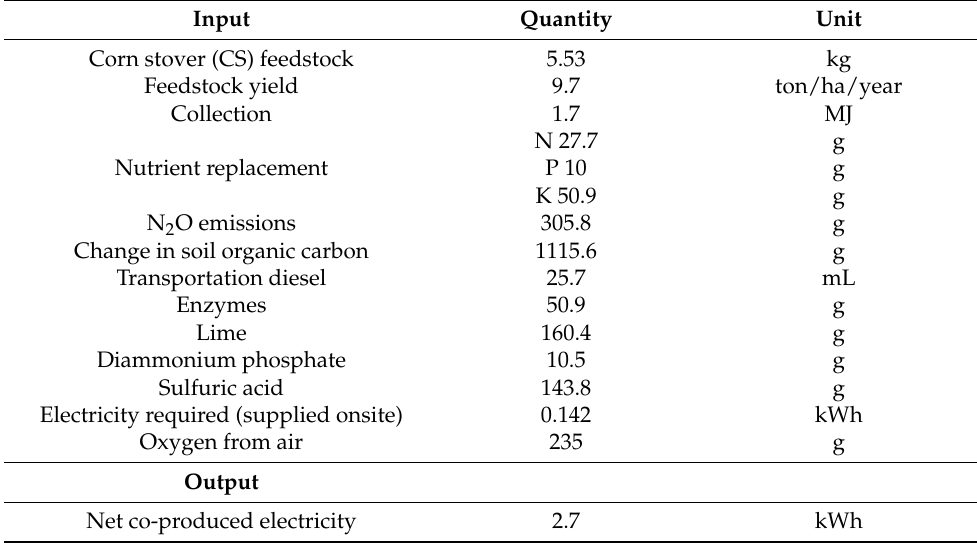
Table 2. summarizes the inputs of feedstock, chemicals, and energy on a functional unit basis of 1 kg polyisoprene. We assume that the corn stover supply shed yields meet the biorefinery feedstock demand and that there is no competition with other uses for the corn stover. Table 2. LCI summary of cradle-to-gate feedstock, chemicals, and energy inputs and co-product outputs in the biorefinery. All data expressed per 1 kg Polyisoprene produced.